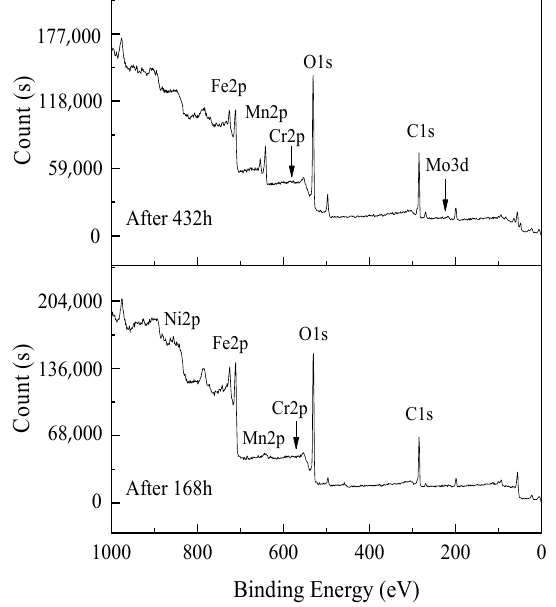
Figure 7. XPS survey spectra of corrosion products formed after 168 h and 432 h corrosion.